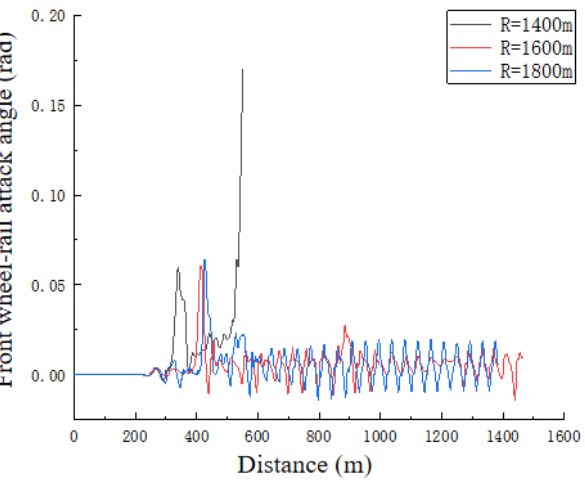
Figure 12. Attack angle of the train running on group B under nonlinear critical speed.